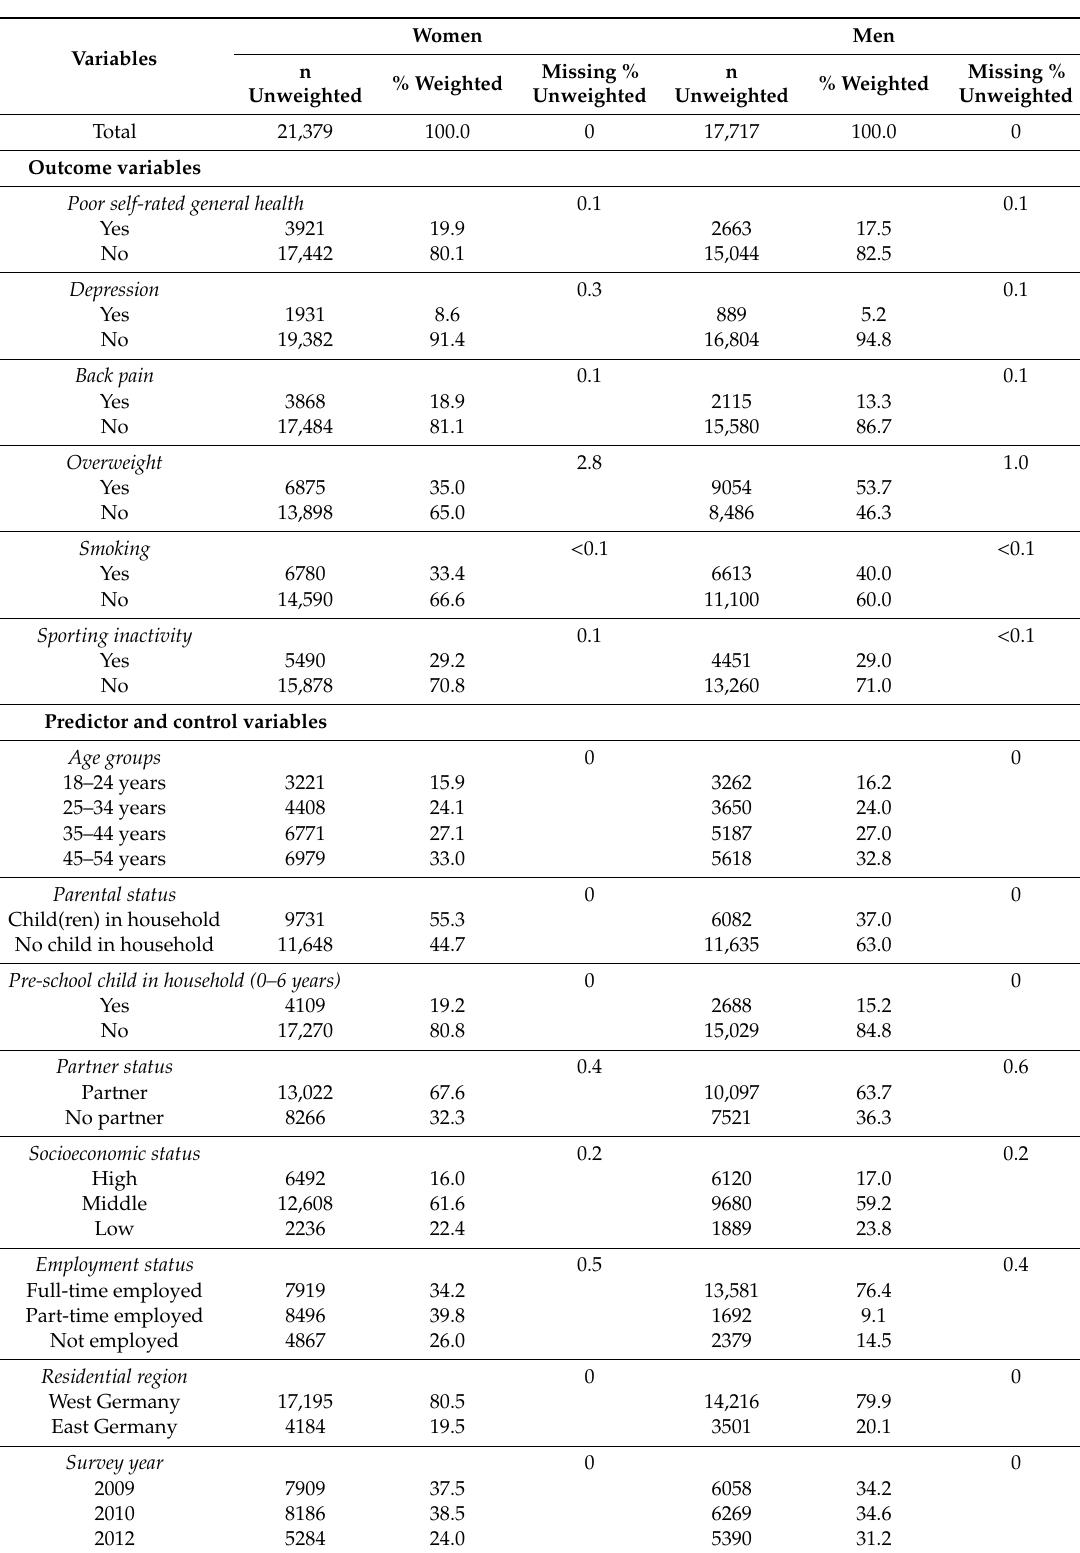
Table 1. Description of the